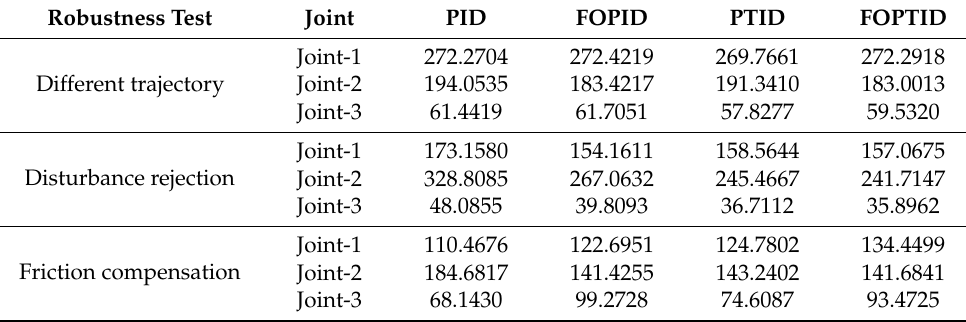
Table 3. RMS values of the control signals for robustness